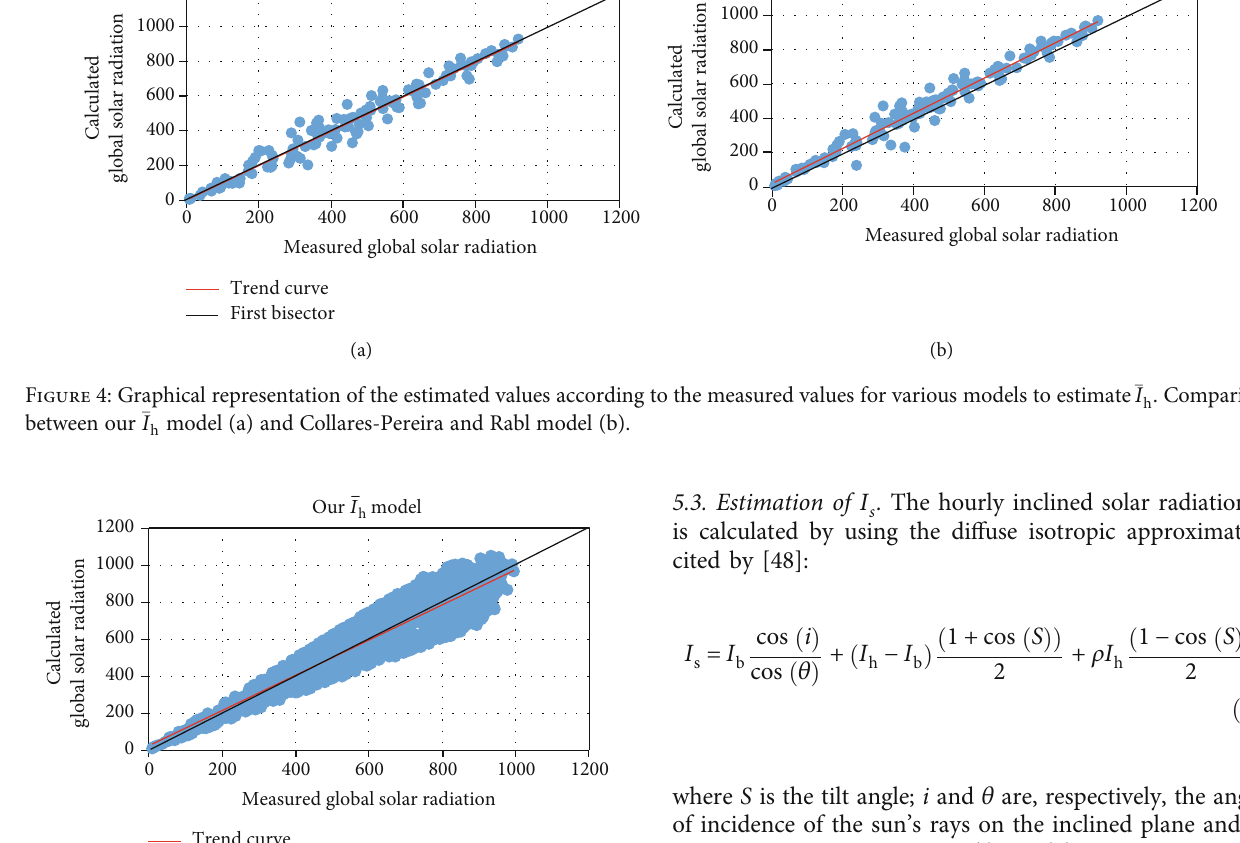
Figure 5: Graphical representation of the estimated values according to the measured